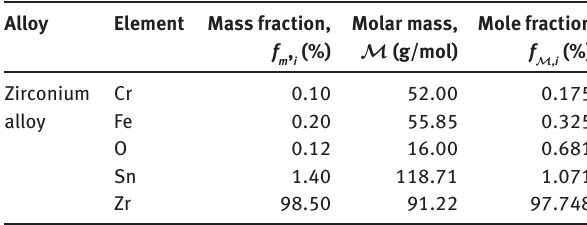
Table 1: Chemical composition of the considered zirconium alloy (Zircaloy-4). Alloy Element Mass